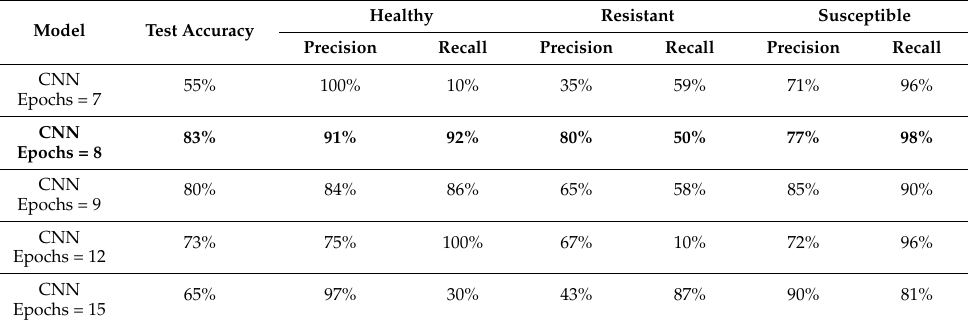
Table 2. Results for models trained on high-resolution images.